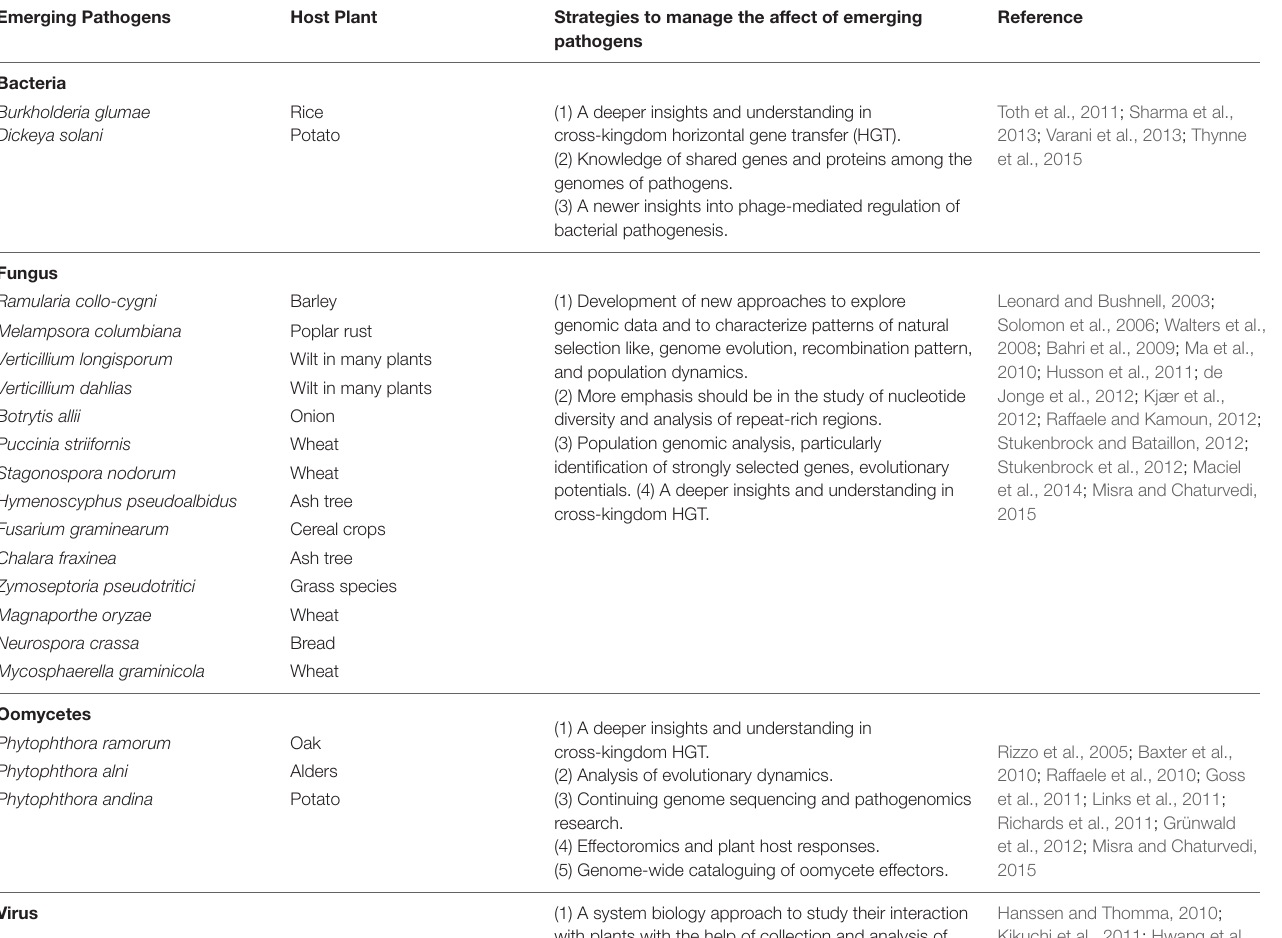
TABLE 2 | List of emerging phytopathogens and strategies to manage the affects of emerging pathogen. Emerging